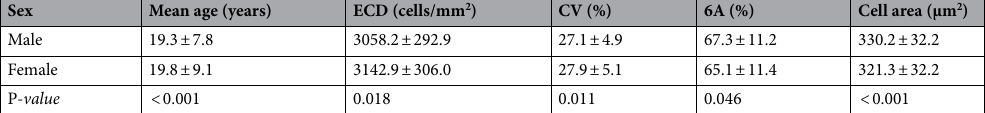
Table 4. Comparison of endothelial cell density and morphology of healthy Japanese eyes according to sex. ECD, corneal endothelial cell density; CV, coefficient of variation in cell area; 6A, appearance rate of hexagonal